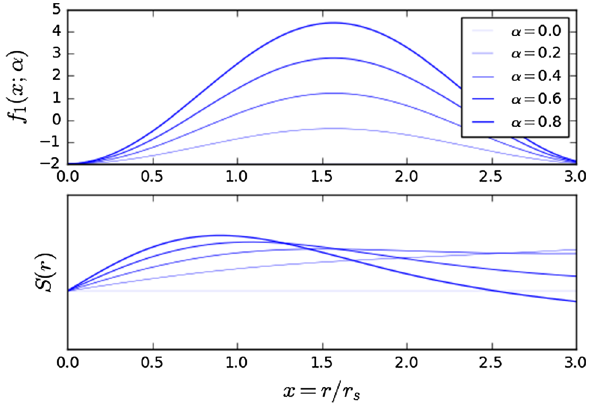
Fig. 1 f 1 ( r ; α) (top) along the galactic disc for different values of α and their corresponding S solution (bottom). Notice that small values of α give rise to negative f 1 which correspond to monotonic solutions while solutions with large α have a more complex oscillatory behavior